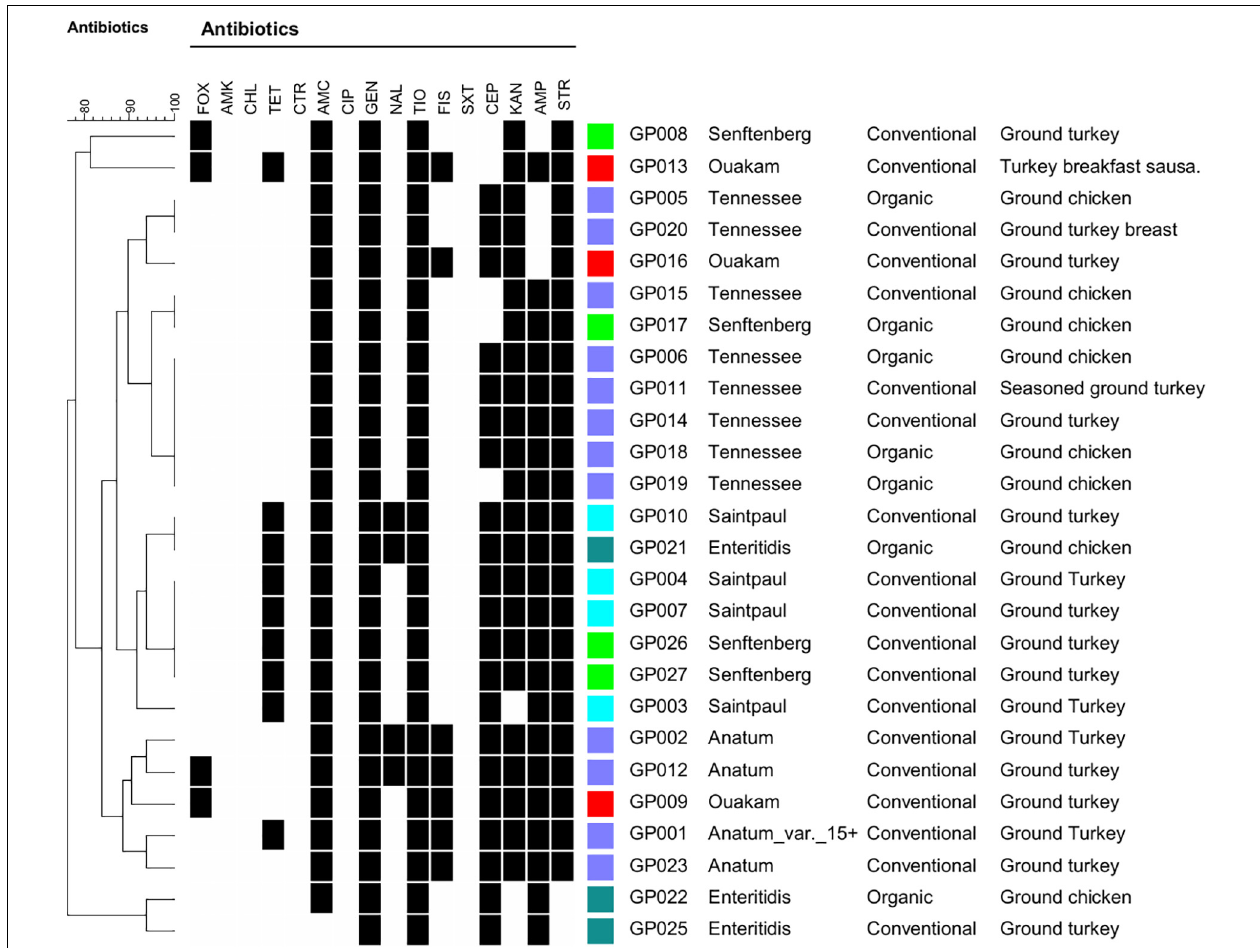
FIGURE 1 | Dendrogram of 26 Salmonella strains showing antibiotic resistance profiles, serotypes, and sources of ground poultry. Clustering was based on antibiotic resistance profiling, and the dendogram was created using BioNumerics software. Black squares indicate resistance. Abbreviations: FOX, cefoxitin; AMK, amikacin; CHL, chloramphenicol: TET, tetracycline; CTR, ceftiaxone; AMC, amoxicillin-clavulanic acid; CIP, ciprofloxac; GEN, gentamicin; NAL, nalidixic acid; TIO, ceftiofur; FIS, sulfisoxazole; SXT, trimethoprim/sulfamethoxazole; CEP, cephalothin, KAN, kanamycin; AMP, ampicillin; STR, streptomycin.